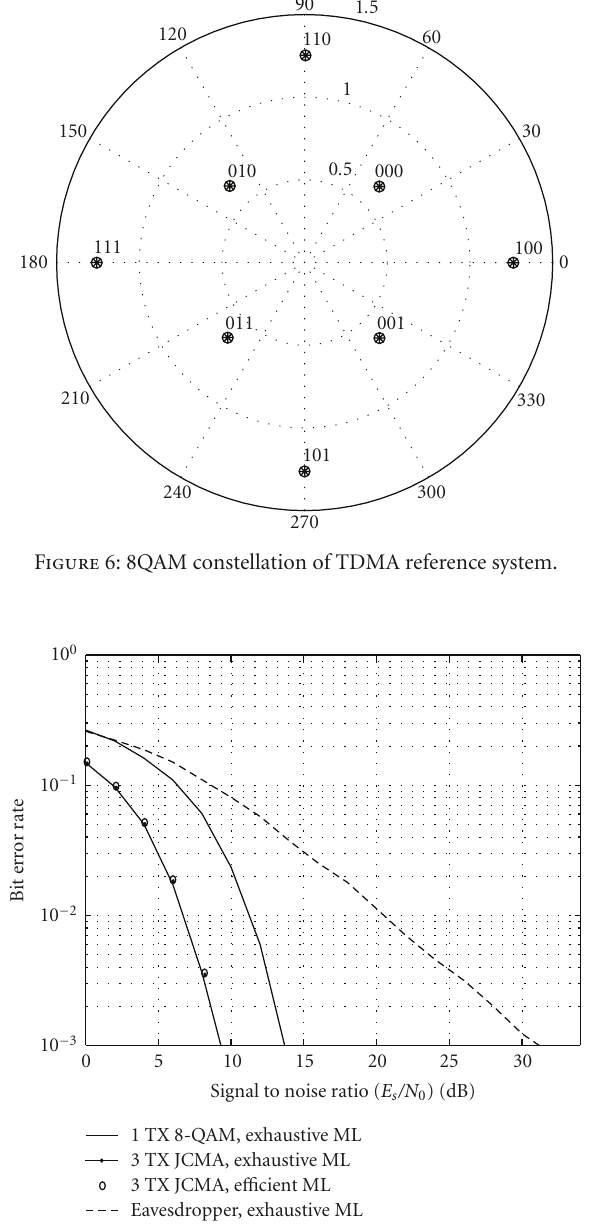
Figure 7: Performance curves for the three transmitters scenario.